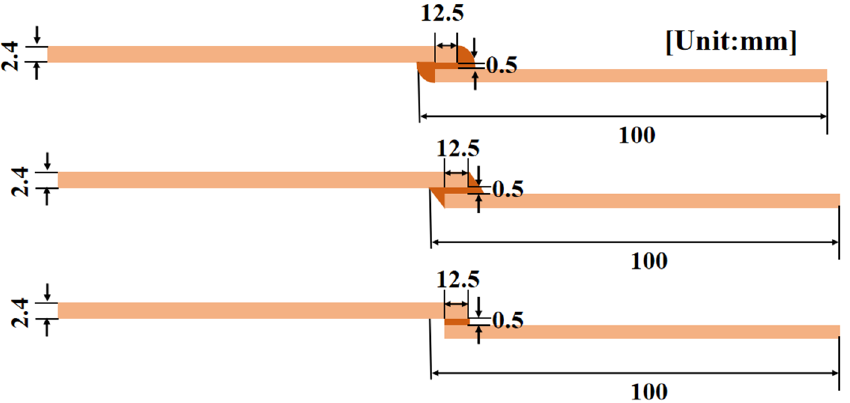
Figure 10. Schematic diagram of different adhesive layer shapes.